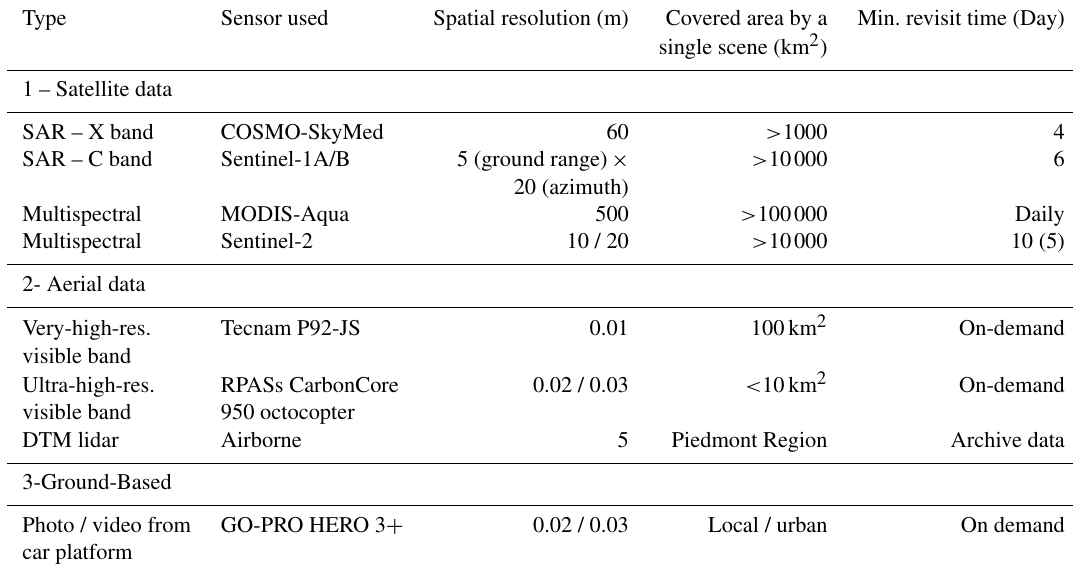
Table 1. Resume of the datasets used to map and characterise flooded areas in this study.